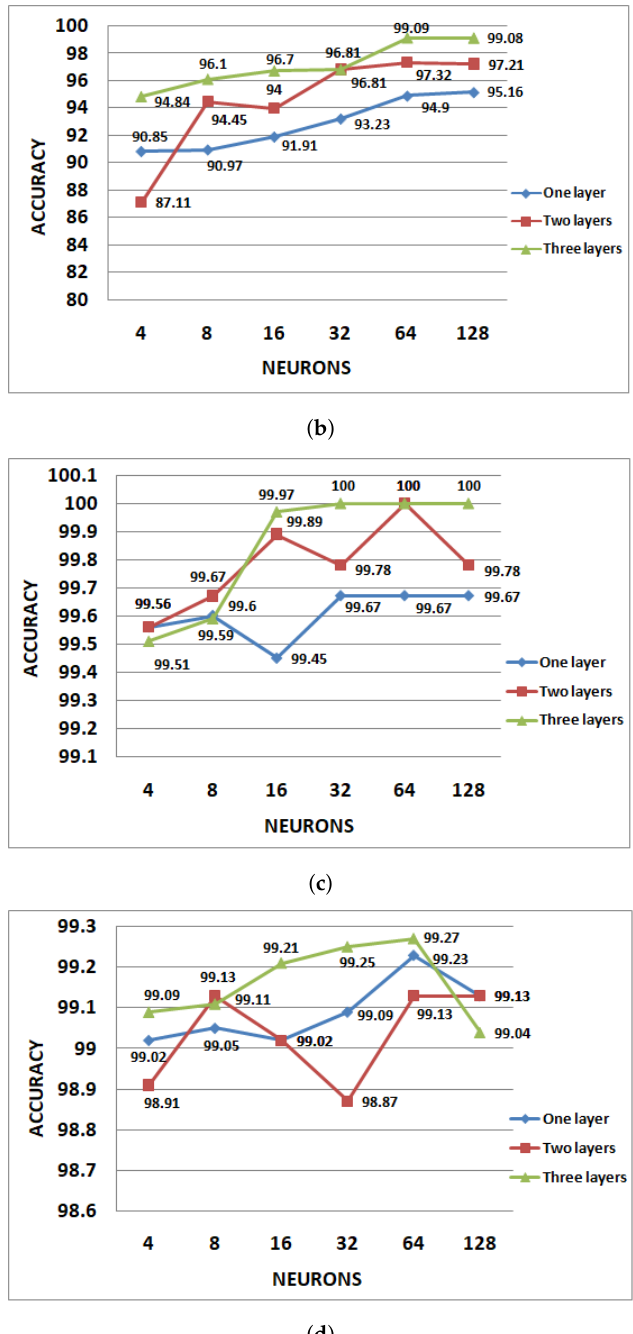
Figure 11. Training performance of DNN model on variety of data. ( a ) Noise level: 10 to 50 (Dataset-1). ( b ) THD level: 10 to 50 (Dataset-2). ( c ) THD level: 50, noise level: 10 to 40 (Dataset-3). ( d ) Noise level: 5 to 20